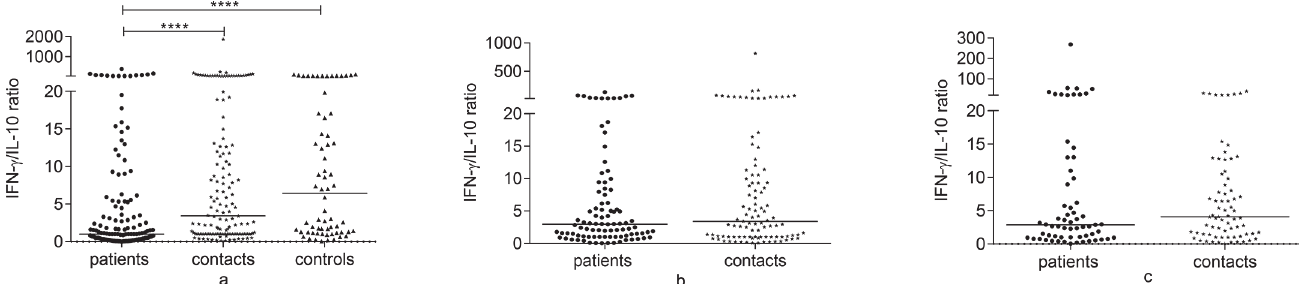
Fig 7. Comparison of IFN- γ /IL-10 ratio among groups at baseline, 6 and 12 months. IFN- γ /IL-10 ratio at baseline (a), 6 months (b) and 12 months (c) following whole blood stimulation with Rv2031 for 48 hours. Filled circles represent patients, filled diamonds represent contacts and filled triangles represent controls. Results are individual responses. Horizontal bars are medians. Kruskal-Wallis test with Dunn ’ s multiple comparisons (a) and Mann-Whitney test (b and C) were used to compare groups. **** p < 0.0001.